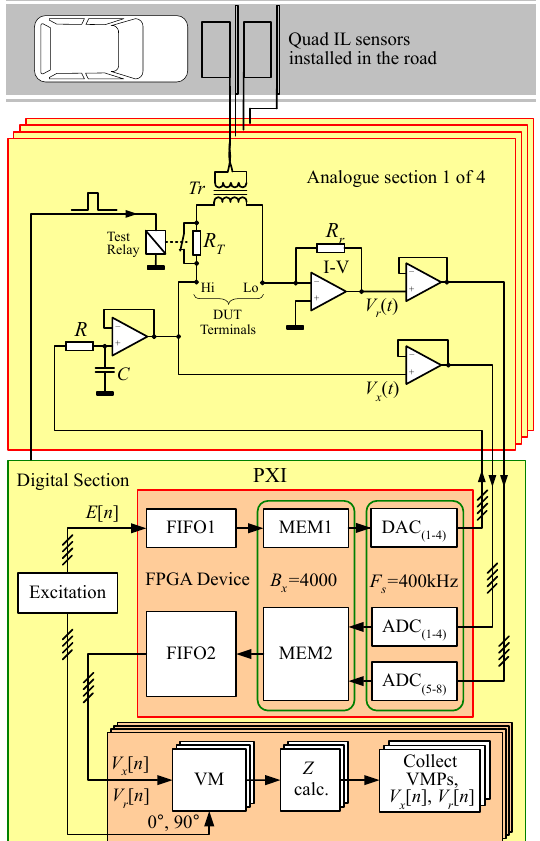
Figure 4. The hardware design of the field-programmable gate array (FPGA)-based four-channel system for multifrequency impedance measurement of IL sensors, where VM is a vector